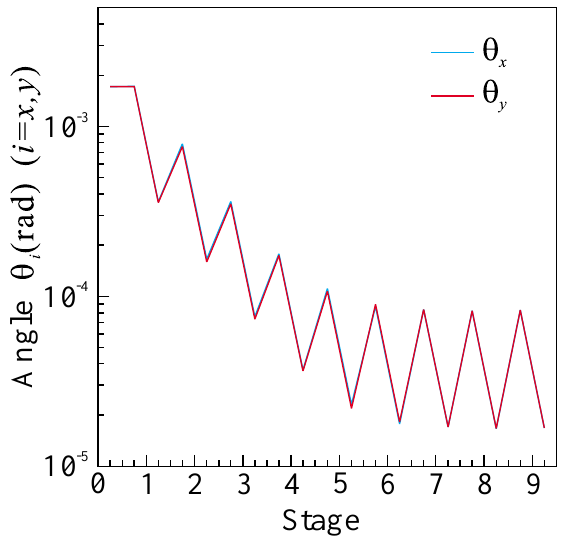
FIG. 5. The longitudinal emittance of the electron